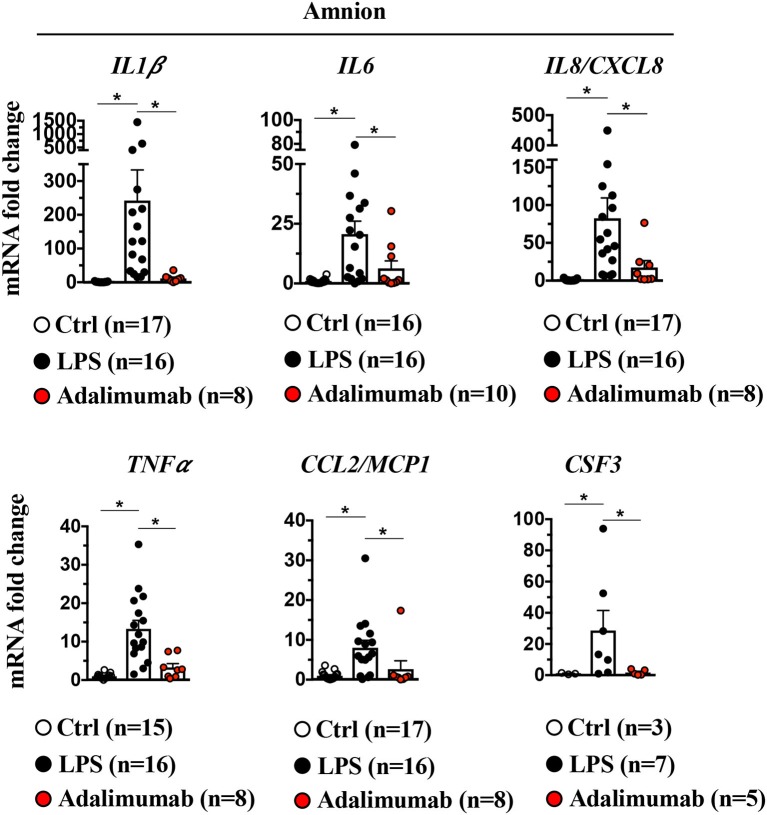
Signaling in amnion: Induction of LPS-induced pro-inflammatory cytokines and neutrophil chemoattractant is TNF-dependent. Amnion was physically separated from chorion and decidua parietalis, and expression of cytokine mRNAs by quantitative PCR (Taqman probes) is shown. Intraamniotic LPS induced IL1β, IL6, IL8/CXCL8 TNFα, CCL2/MCP1, and CSF3. All LPS-induced cytokine/chemokine mRNAs were inhibited by Adalimumab. Average mRNA values are fold increases over the average value for control after internally normalizing to the housekeeping 18S RNA (Ctrl n = 3–17; LPS n = 7–16; Adalimumab n = 5–10). Data are mean ± SEM, *p < 0.05 between comparators (Mann–Whitney U-test).